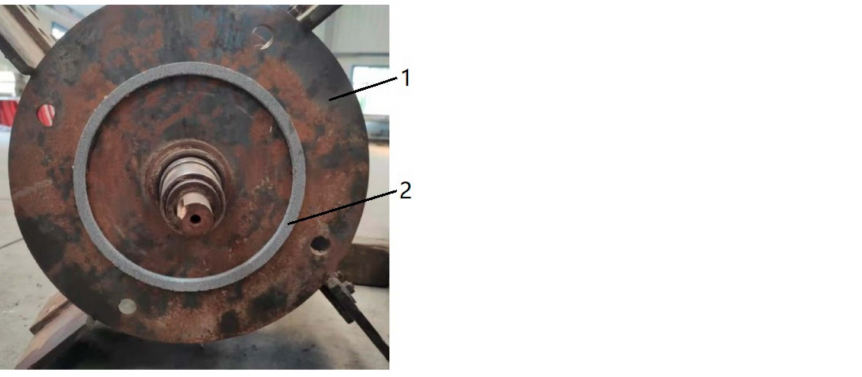
Figure 11. Installation position of the support plate damping ring. (1) Support plate; (2) damping